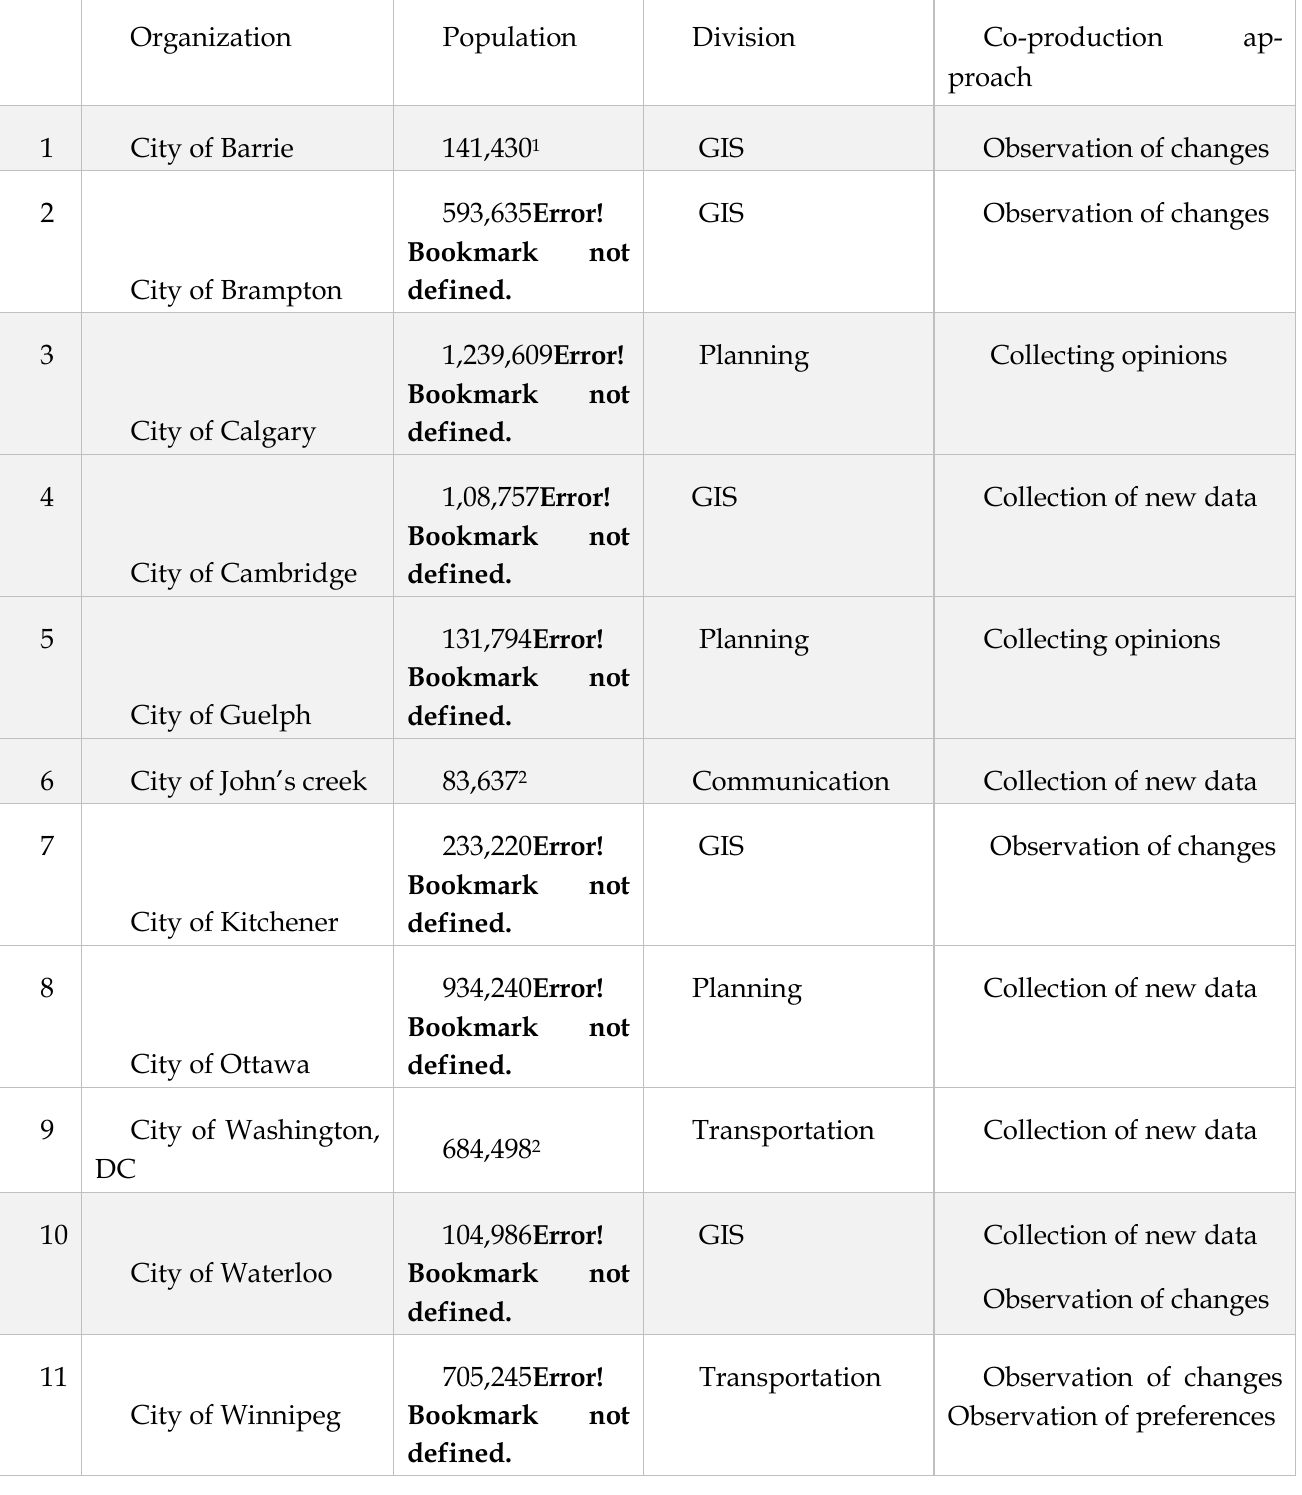
Population Census 2016. Source: Statistics Canada Population Estimates 2018, Source: US Census